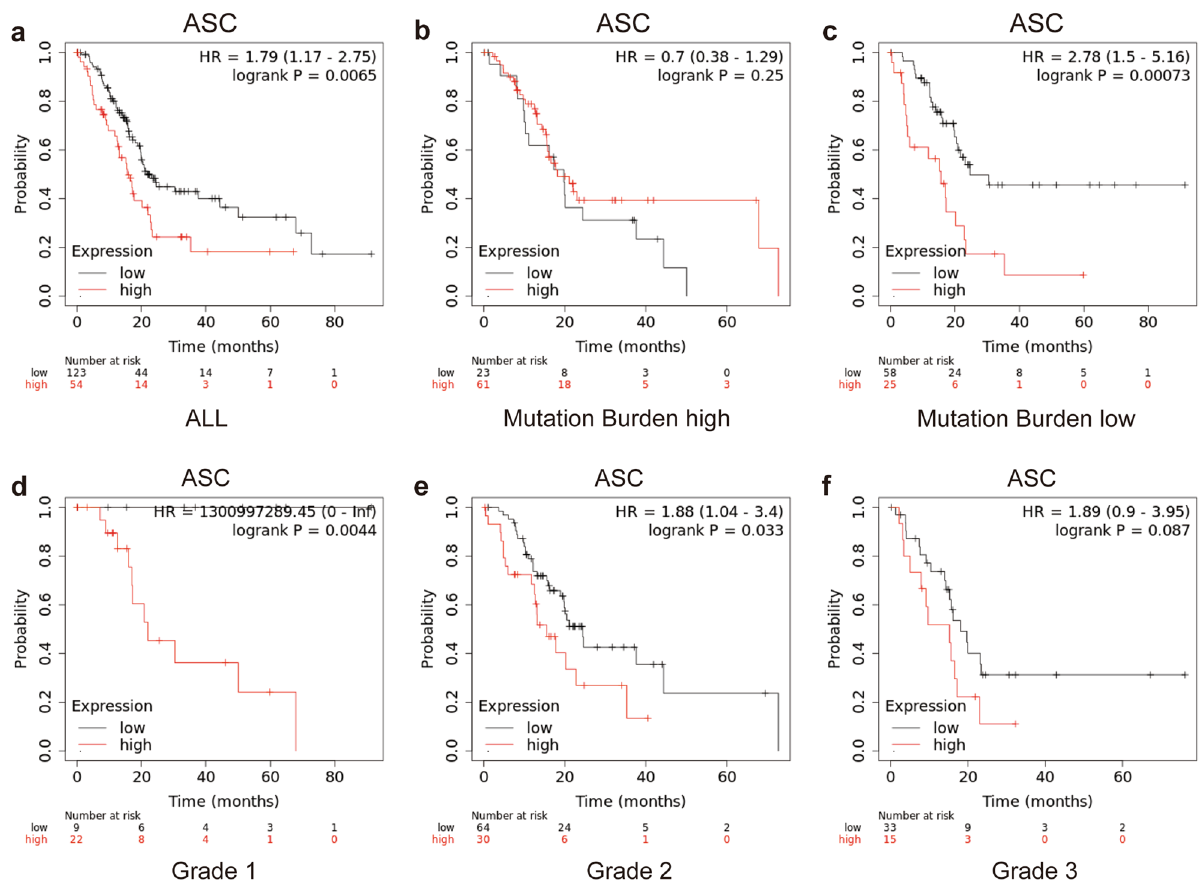
Figure 2. OS evaluated between PDAC patients with high and low expression of ASC. ( a ) OS of all PDAC patients (n = 177) and those with ( b ) high TMB (n = 84) and ( c ) low TMB (n = 83). ( d ) OS of PDAC patients with histological grade 1 (n = 31), ( e ) grade 2 (n = 94), and ( f ) grade 3 (n = 48) tumors. TMB tumor mutation